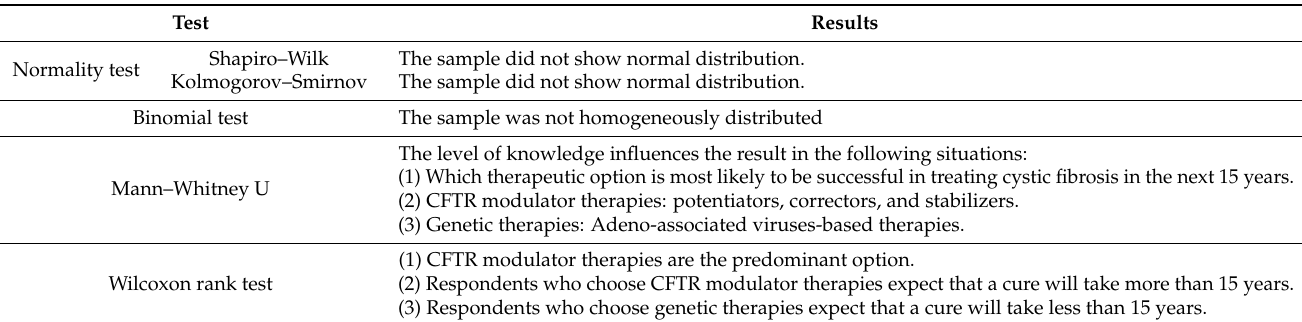
Table 1. Summary of the statistical analysis of the